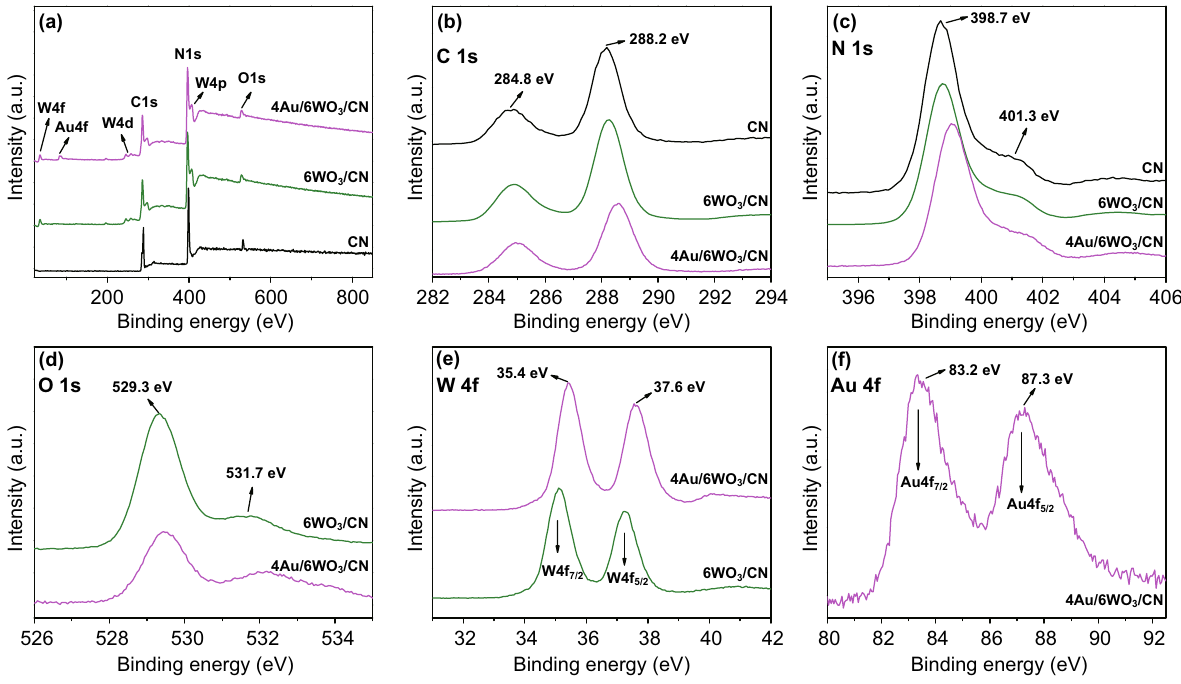
Fig. 3 a XPS survey spectra, b high‑resolution C 1 s XPS spectra, and c high‑resolution N 1 s XPS spectra of CN, 6WO 3 /CN, and 4Au/6WO 3 / CN photocatalysts. High‑resolution d O 1 s XPS spectra, and e W 4 f XPS spectra of 6WO 3 /CN and 4Au/6WO 3 /CN photocatalysts. f High‑resolu‑ tion Au 4 f XPS spectra of 4Au/6WO 3 /CN